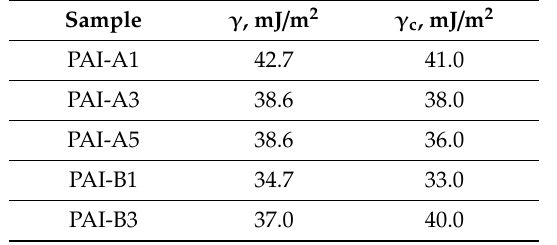
Table 4. PAI critical surface tension according by [17].